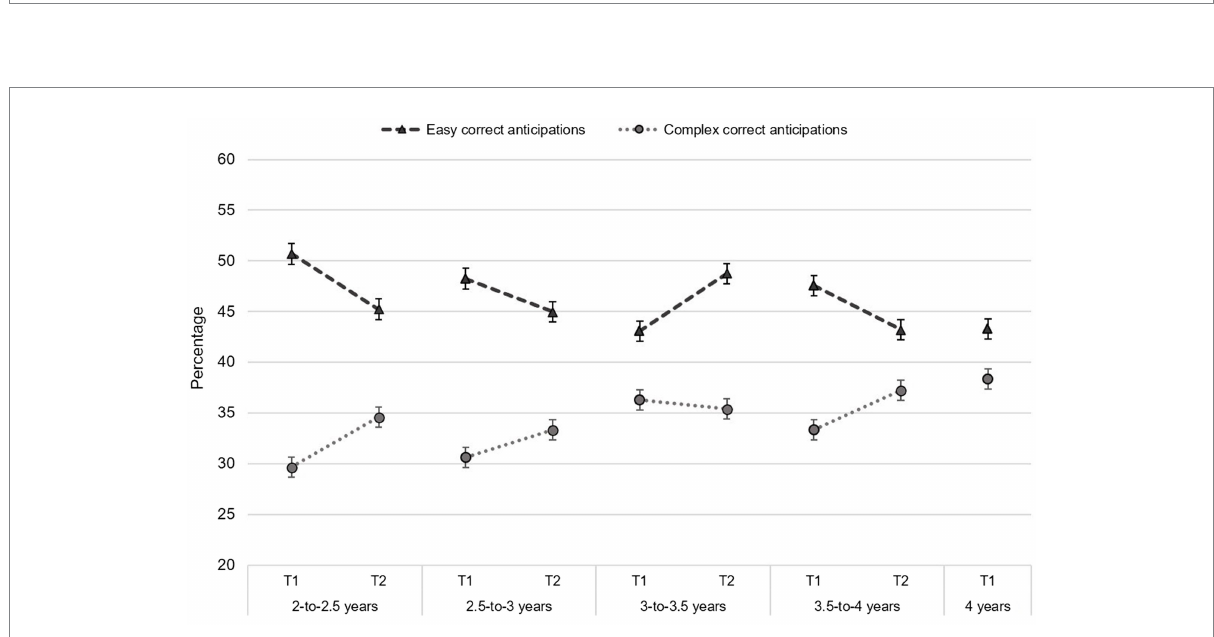
FIGURE 3 Proportion of easy and complex correct anticipations. Scores are displayed for each age group in the first (T1) and follow-up (T2) session. The 4-year-old group was only evaluated in the first session and not followed over